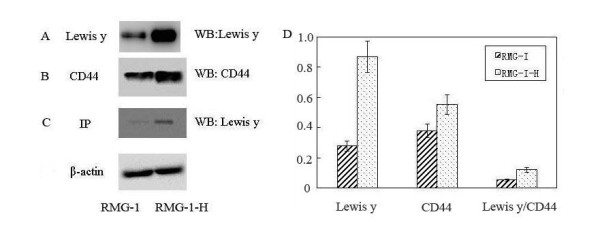
The expression of CD44 and Lewis y antigen in RMG-I and RMG-I-H cells. Panel A shows the expression of Lewis y antigen in RMG-I-H cells was higher than that in RMG-I; panel B shows the expression of CD44 in RMG-I-H cells was higher than that in RMG-I; panel C shows that Lewis y antigen, which in RMG-I-H cells was higher than that in RMG-I, was expressed both in RMG-I and RMG-I-H cells after CD44 immunoprecipitation; panel D Quantitative data were expressed as the intensity ratio target genes to beta-actin. (P < 0.01)